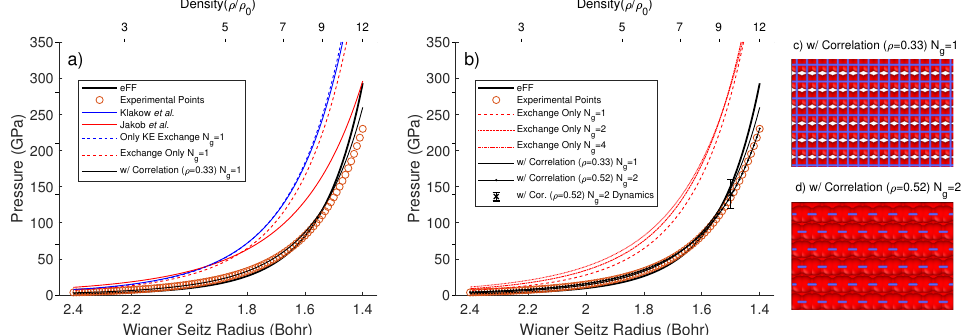
Figure 5. The pressure of dense hydrogen. ( a ) A comparison of our results to those in the literature for a single-Gaussian basis. Our results were calculated at 0 K, whereas the published results, both experimental and theoretical, were calculated at 300 K. The small offset between the Klakow et al. results and our results using purely the kinetic energy component of exchange demonstrate the applicability of this approximation. ( b ) Extension to multiple Gaussians. The red lines, calculated with pairwise exchange only, show that increasing the number of Gaussians has only a small effect on the pressure curve. The VB correction is needed to best match experimental results. ( c ) Orthorhombic crystal structure of hydrogen at a Wigner–Seitz radius of 1.6 Bohr for a single-Gaussian basis and scaled VB correction ( ρ = 0.33). ( d ) Hexagonal-close-packed crystal structure of hydrogen at a Wigner–Seitz radius of 1.6 with a two-Gaussian basis and scaled VB correction ( ρ =